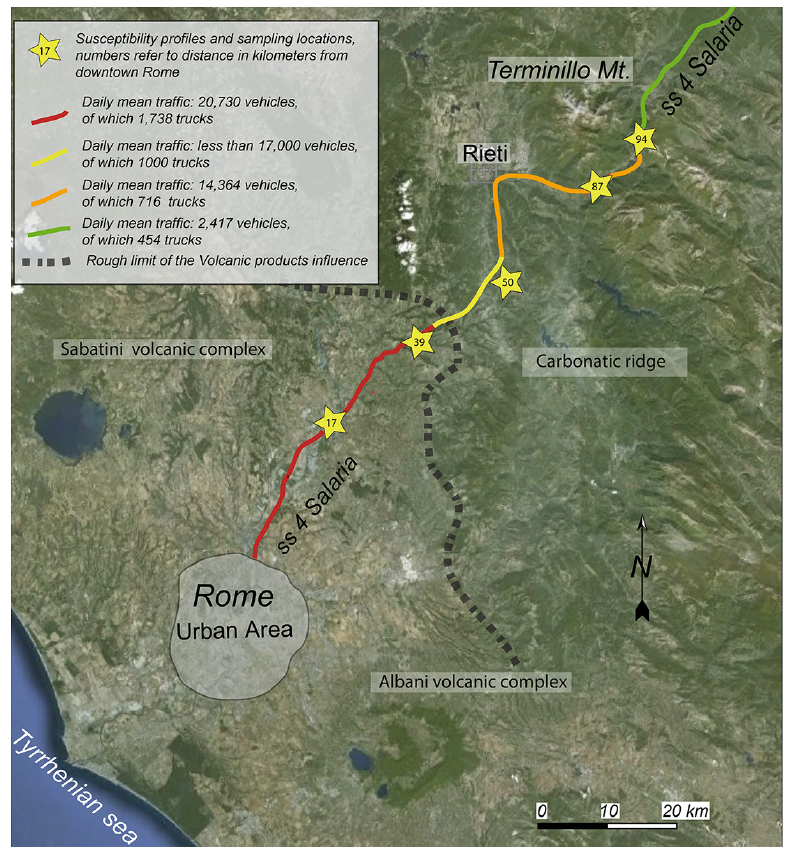
Figure 1. Location map of the study area, stars locate the sampling sites, symbols as in legend. Site denomination follows the kilometric dis- tance from downtown Rome along the state Salaria road